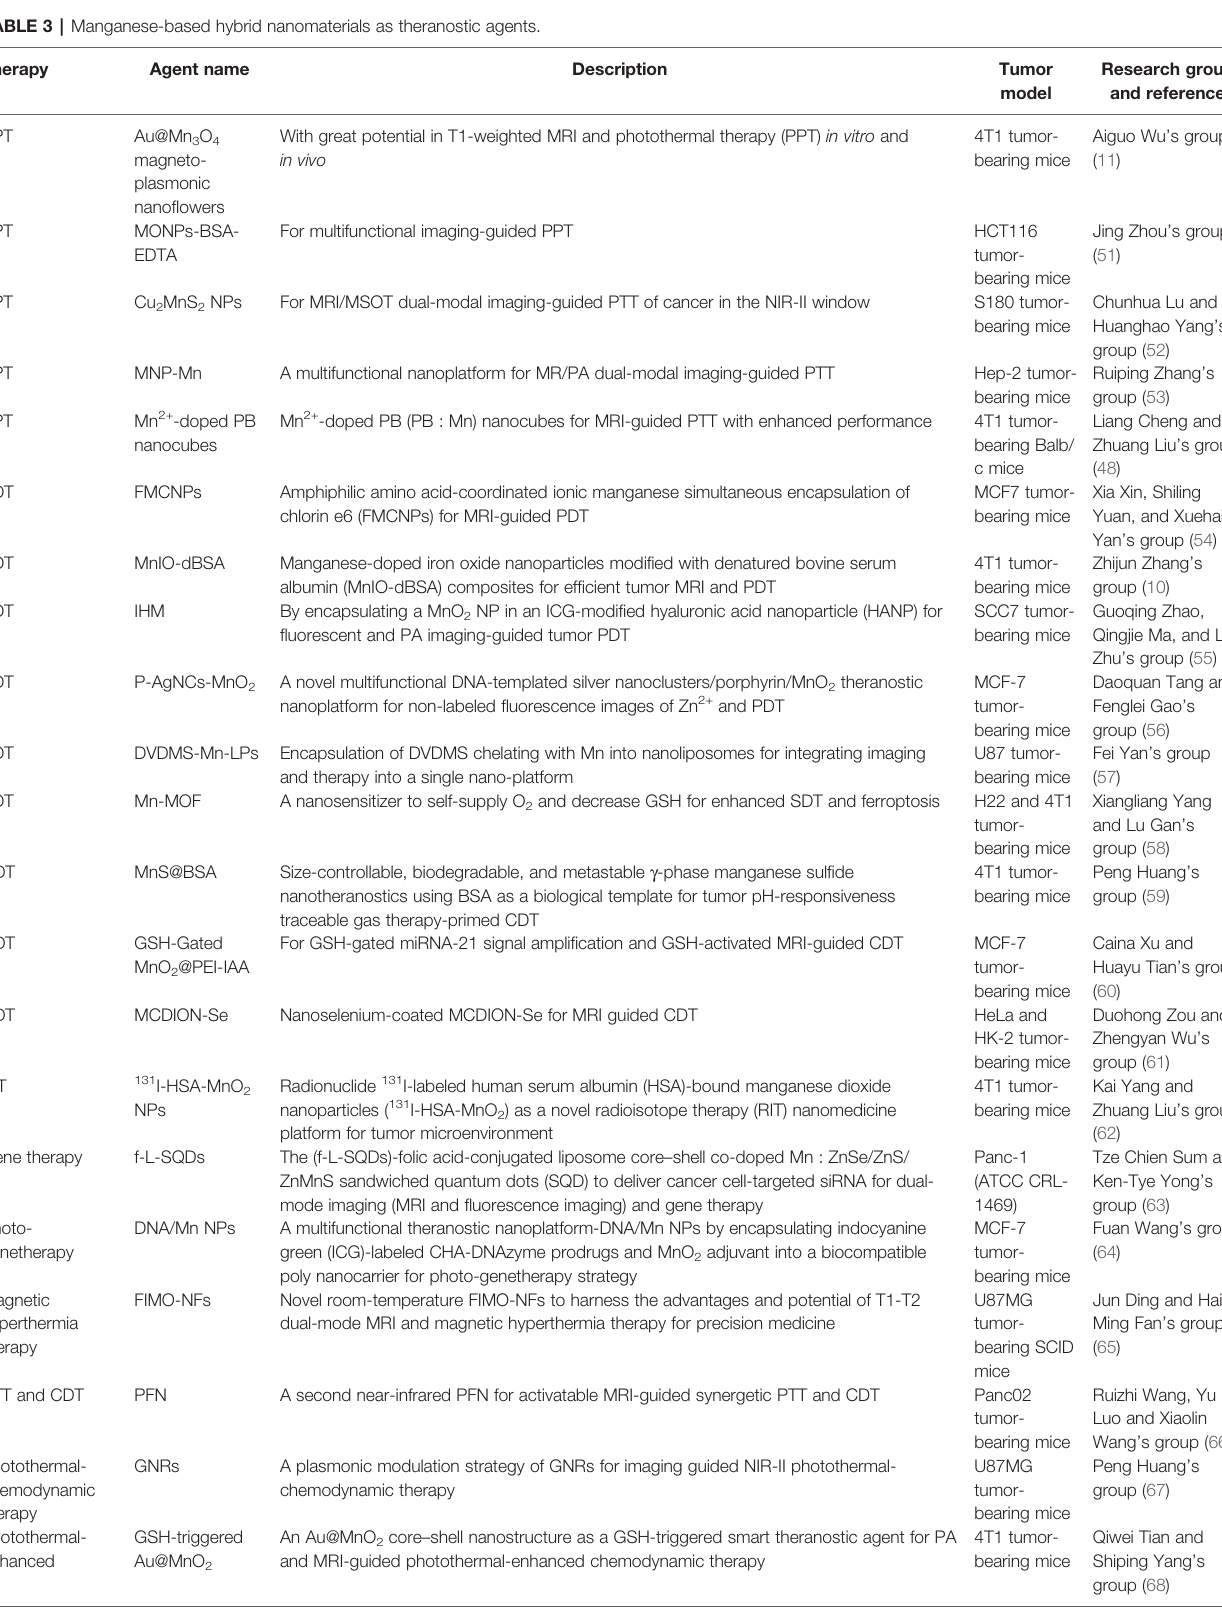
TABLE 3 | Manganese-based hybrid nanomaterials as theranostic agents.